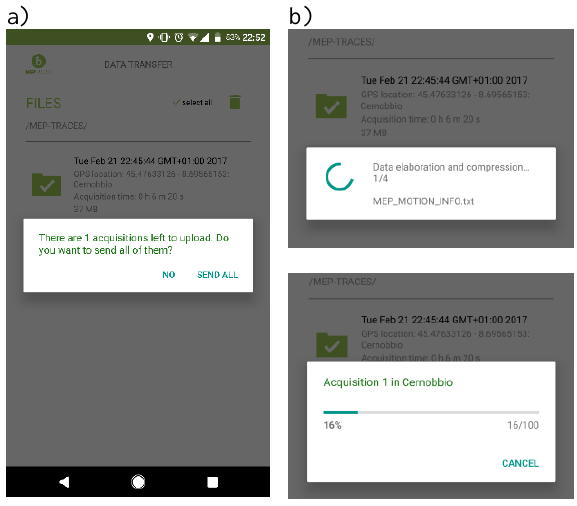
Figure 3. MEP-Traces upload interface example: (a) automatic selection of all the acquisitions, (b) data compression and connection/uploading task